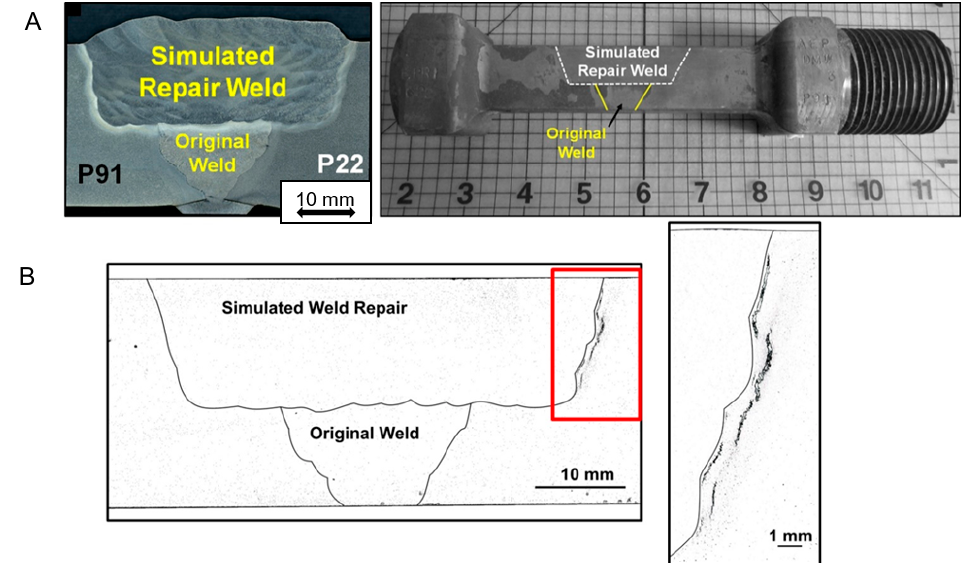
Figure 14. Example of a feature test cross weld specimens used by EPRI, ( A ) containing a simulated weld repair and ( B ) showing HAZ creep damage in a dissimilar metal repair weld between Grade 91 and Grade 22 Steels.